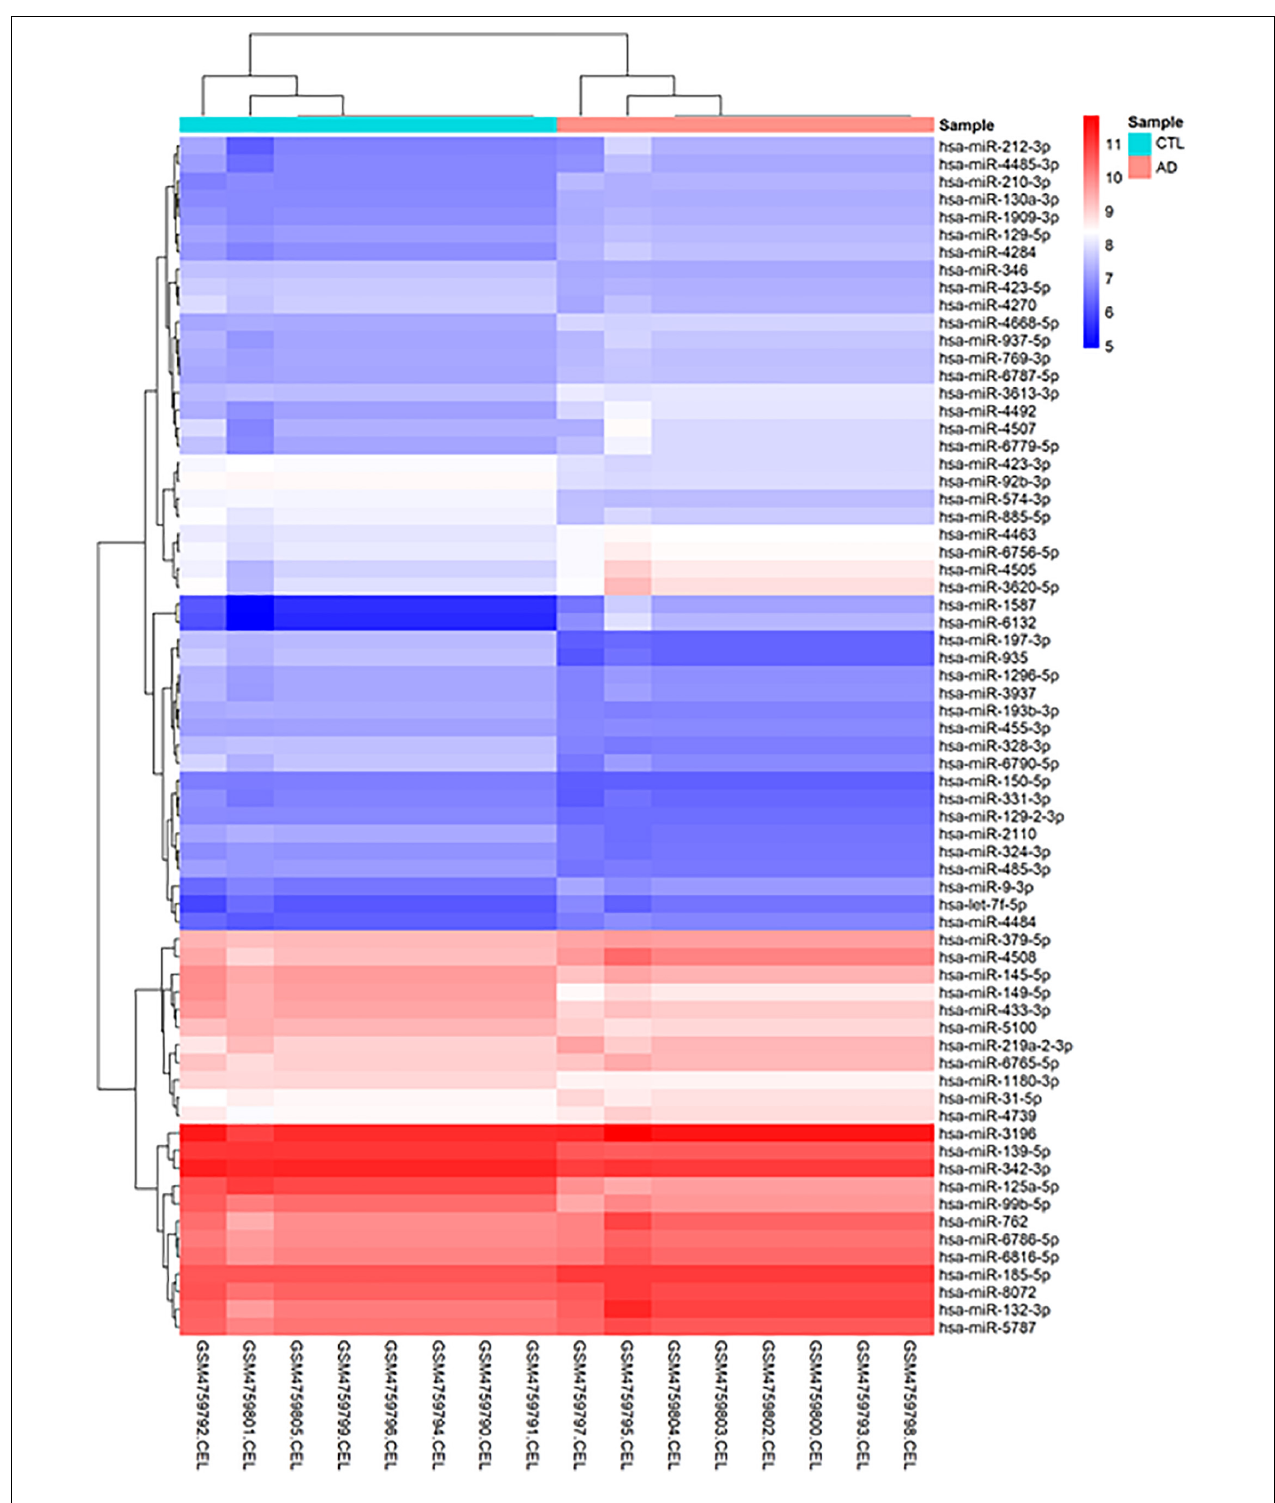
FIGURE 2 | Hierarchical clustering heatmap differentially expressed human miRNAs between brain samples of Alzheimer’s disease (AD) and control (CTL) samples. High expressed genes are shown in red, while those expressed at low levels are blue.